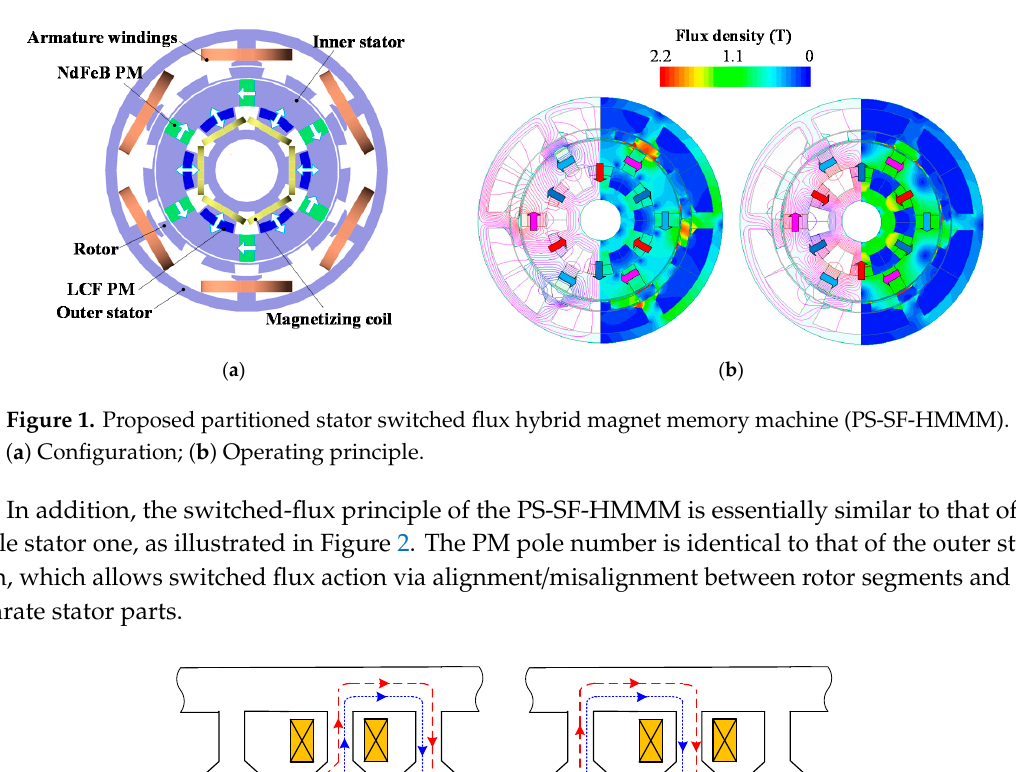
Figure 2. Switched-flux principle of proposed PS-SF-HMMM. ( a ) Rotor position A; ( b ) Rotor position B.